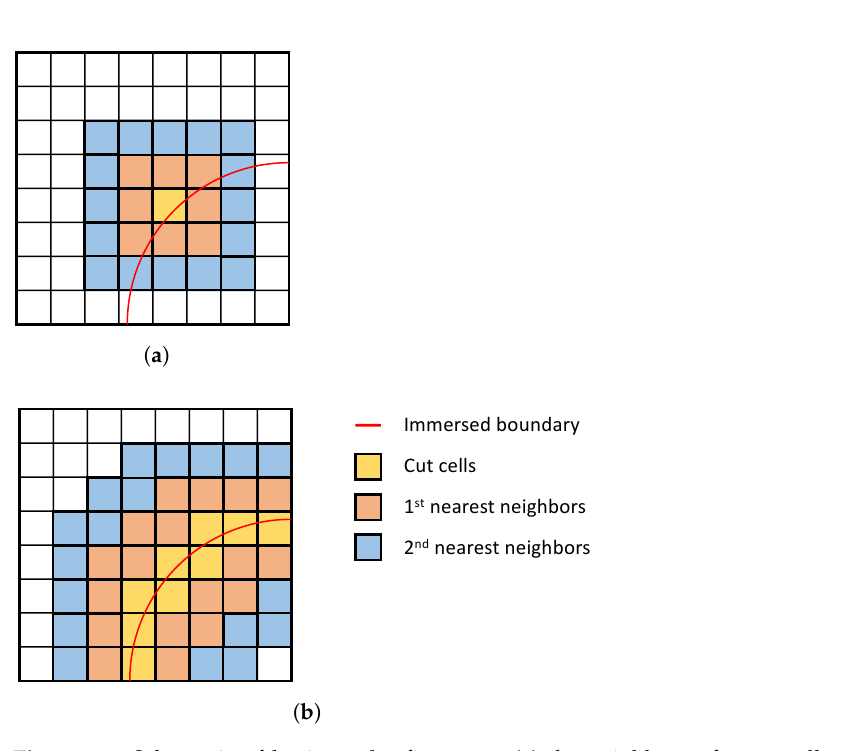
Figure 17. Schematic of horizontal refinement: ( a ) the neighbors of a cut cell provide a larger refinement region, while ( b ) the union of the neighbors forms a refinement band.